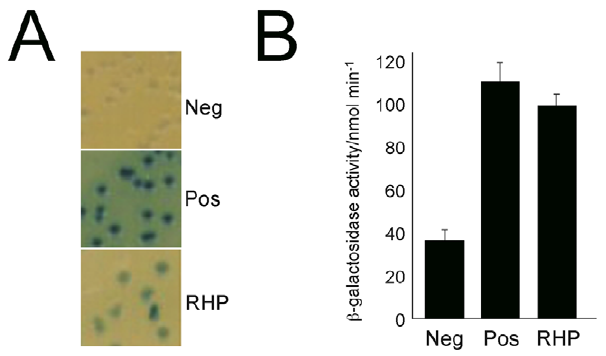
Figure 9. Validation of TbRHP and TbRACK interaction. (A) Bacterial two hybrid mating assay for interaction between TbRHP and TbRACK (Tb11.01.3180). Blue colonies are detected on beta-Gal plates after 48 hours growth in E. coli for both a positive control and TRACK. (B) Quantitation of galactosidase activity in cells harboring the TbRHP bait plasmid and a negative control (irrelevant insert) or TRACK (Tb11.01.3180) and a positive control pair of